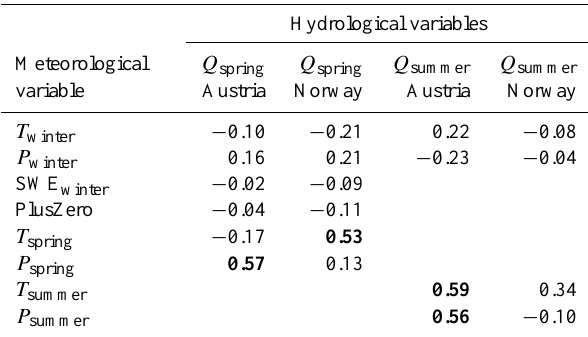
Table 3. Correlation between Q spring and possible related meteoro- logical factors for snowmelt drought and between Q summer and pos- sible related meteorological factors for glaciermelt drought . Corre- lations above 0.5 are indicated in bold